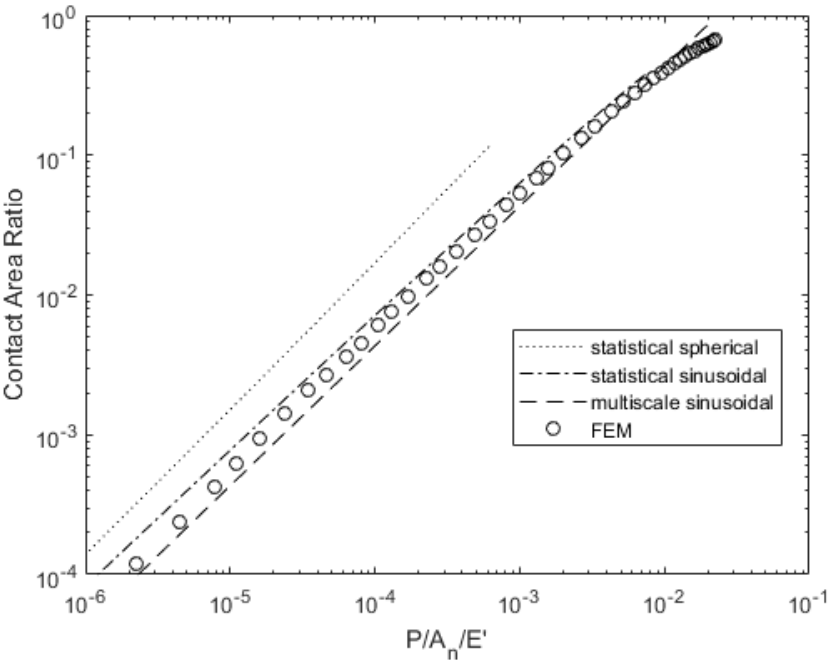
Figure 8. Load-dependent contact area variation for surface 4L.